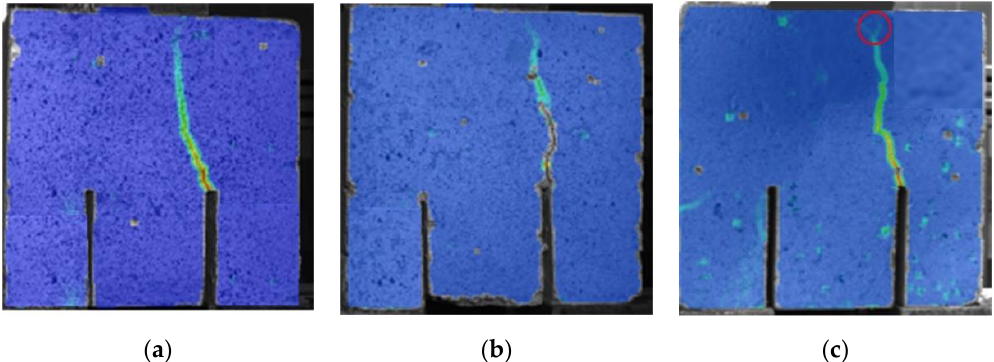
Figure 11. Examples of crack shapes observed in the studies using digital image correlation (DIC) technique: ( a ) quasi-straight crack for concrete specimen LCFA-00; ( b ) slightly curved crack for concrete specimen LCFA-20; ( c ) strongly curved crack for concrete specimen LCFA-30.